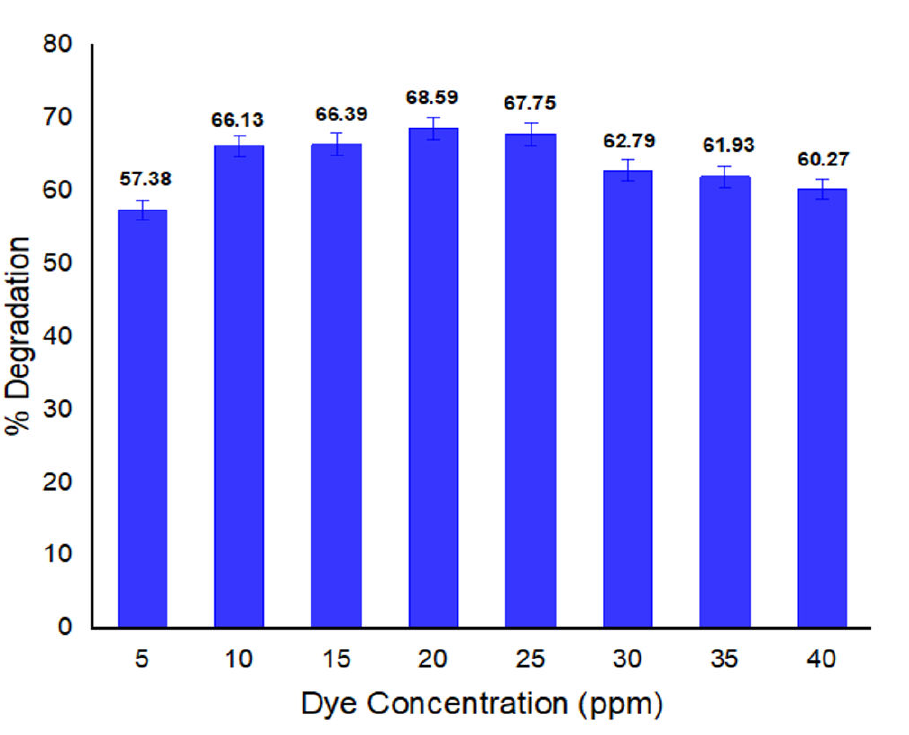
Figure 2. Dye concentration impact on %